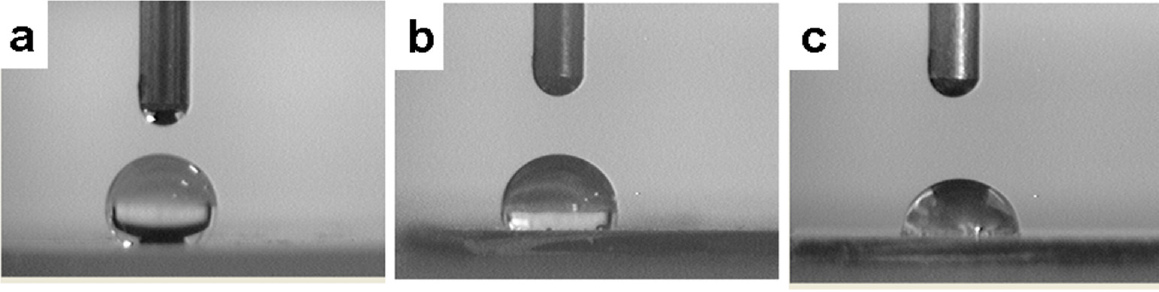
Figure 8. XPS spectra of the polyphosphazene microsphere surfaces.